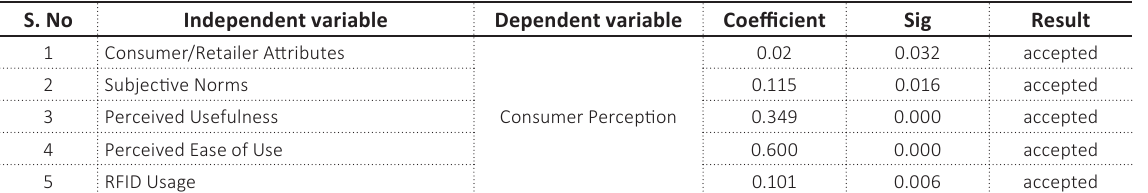
Table 6. Hypotheses testing (dependent variable – consumer perception) S.